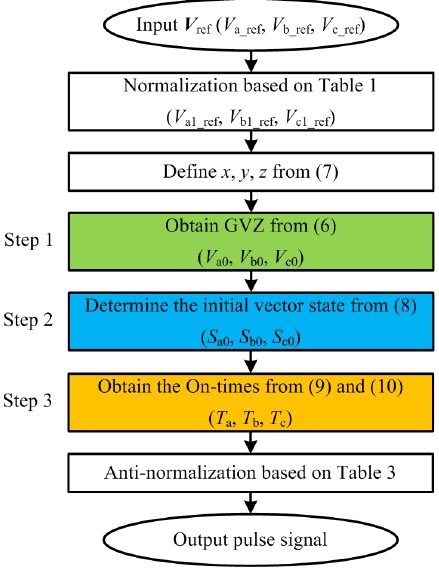
Figure 9. Flowchart of the proposed space vector modulation (SVM) scheme.